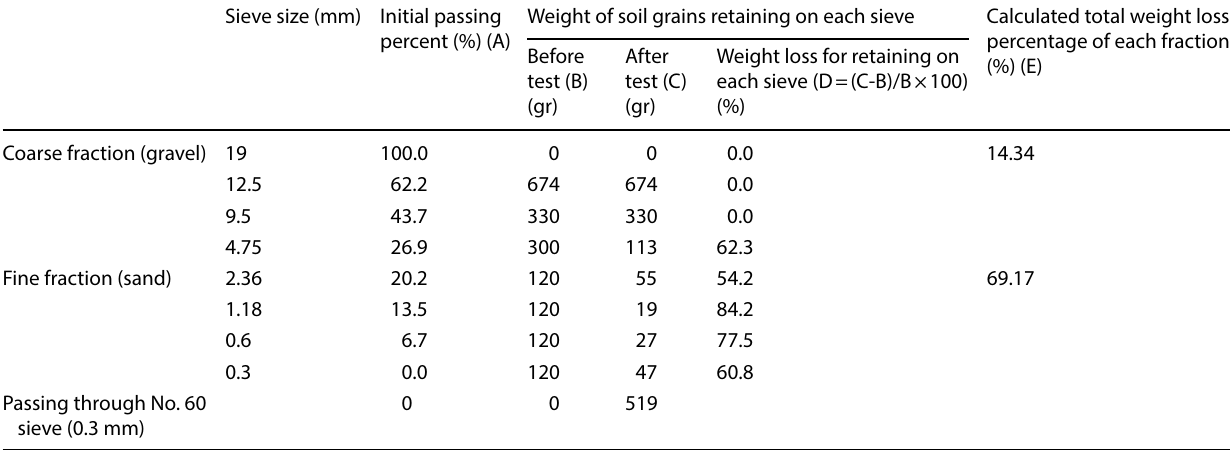
Table 4 The result of freeze–thaw test for the native soil aggregates